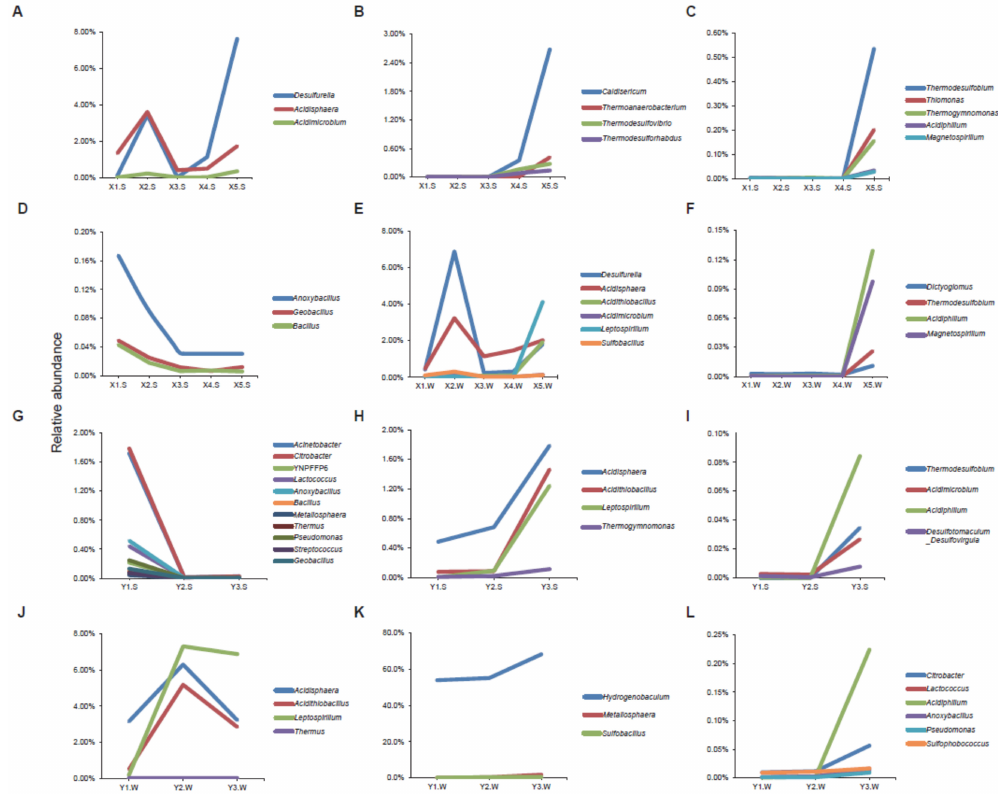
Figure 7. The trends of microbial community abundance with the current of stream. Panel one and two for stream X sediments group, ( A ) increase-decrease-increase-increase model, ( B ) constant- constant-increase-increase model, ( C ) constant-constant-constant-increase model, ( D ) decrease- decrease-constant-constant model. Panel two for stream X water group, ( E ) increase-decrease- increase-increase model, ( F ) constant-constant-constant-increase model. Panel three for stream Y sediments group, ( G ) decrease-constant model, ( H ) increase-increase model, ( I ) constant-increase model. Panel four for stream Y water group, ( J ) increase-decrease model, ( K ) increase-increase model, ( L ) constant-increase